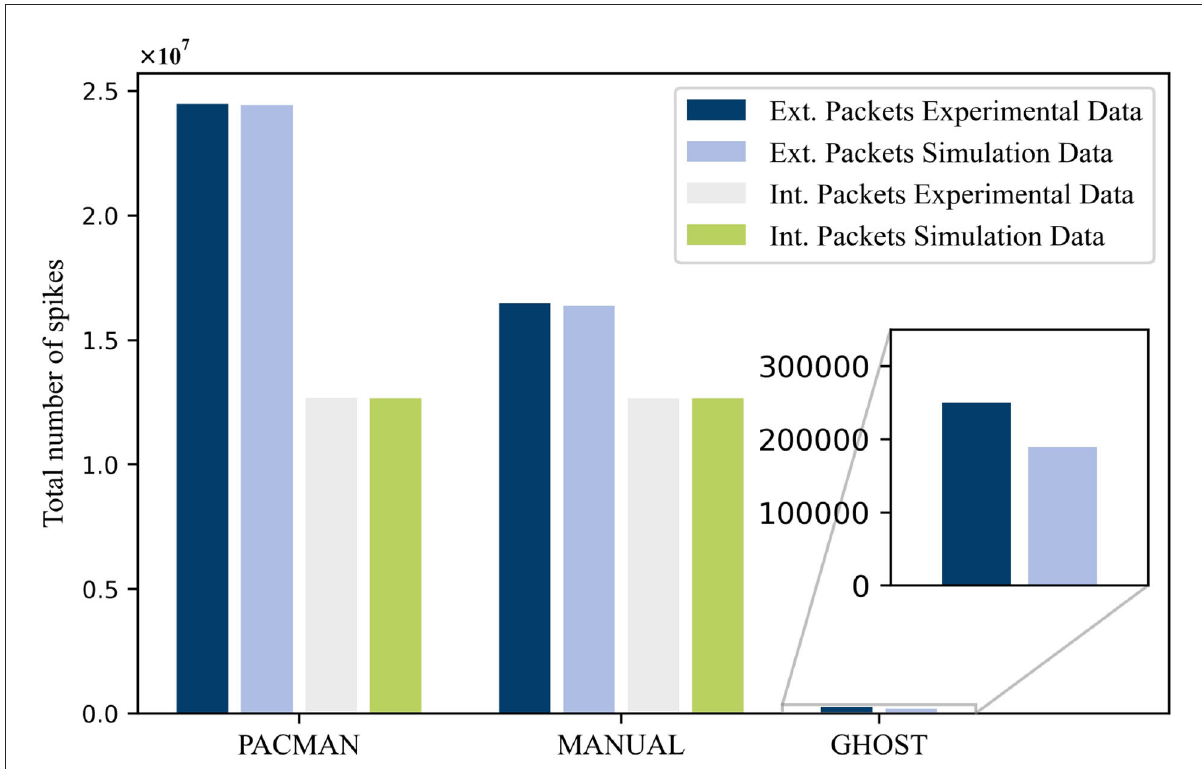
FIGURE4 The total number of spike packets measured in the experimental setup compared with the simulated values for the different mapping procedures.